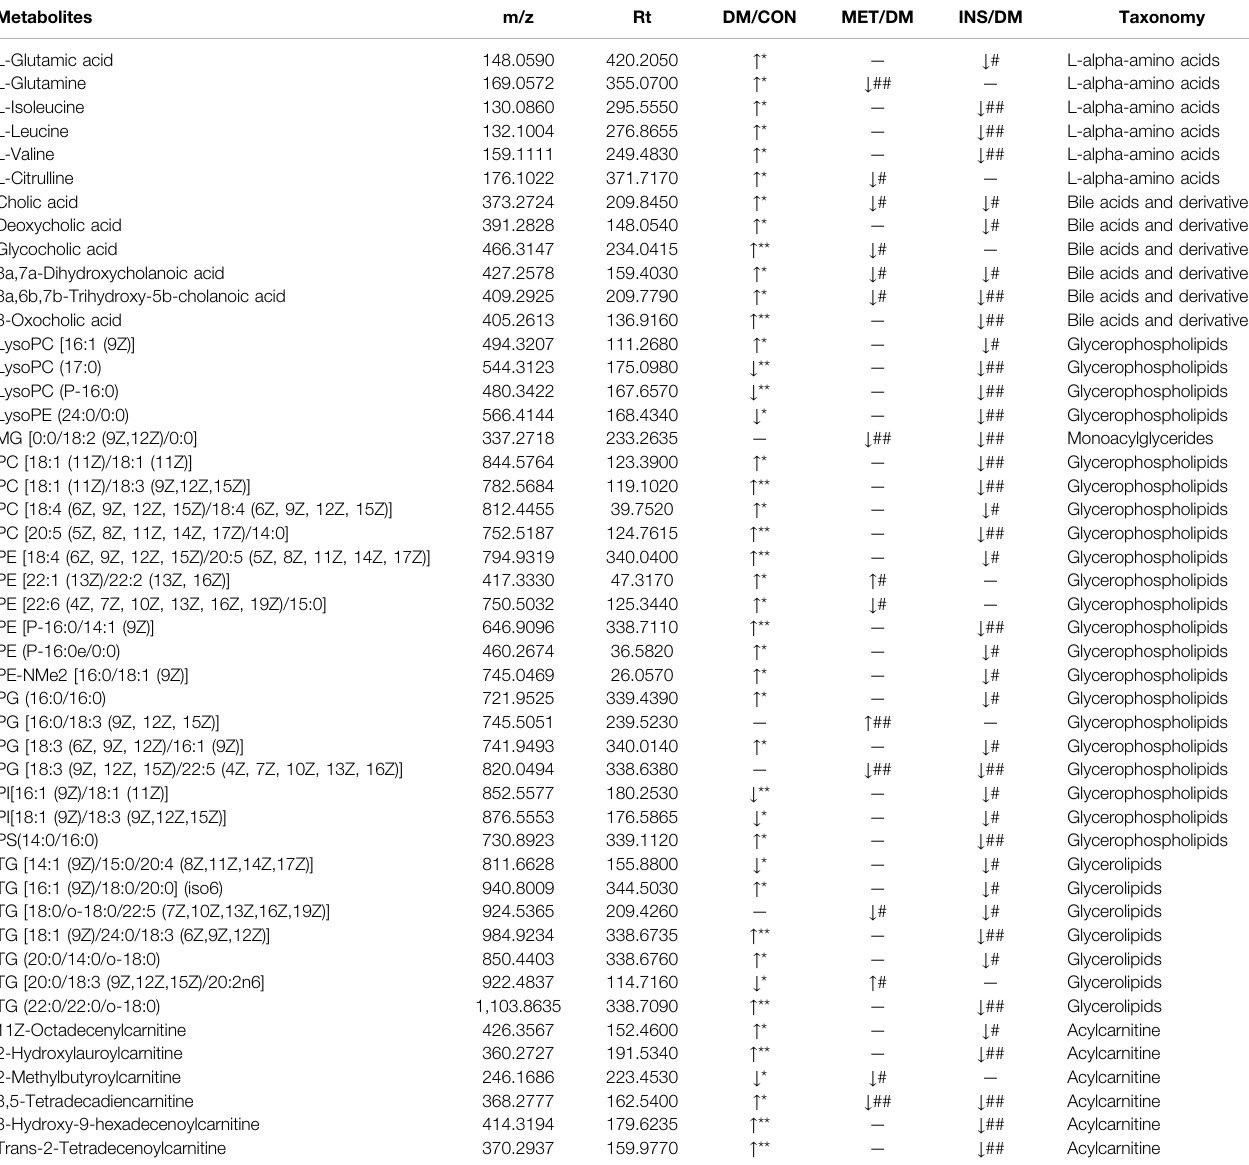
TABLE 2 | The information of metabolites selected as biomarkers characterized in serum pro fi les and their taxonomy. Metabolites m/z Rt DM/CON